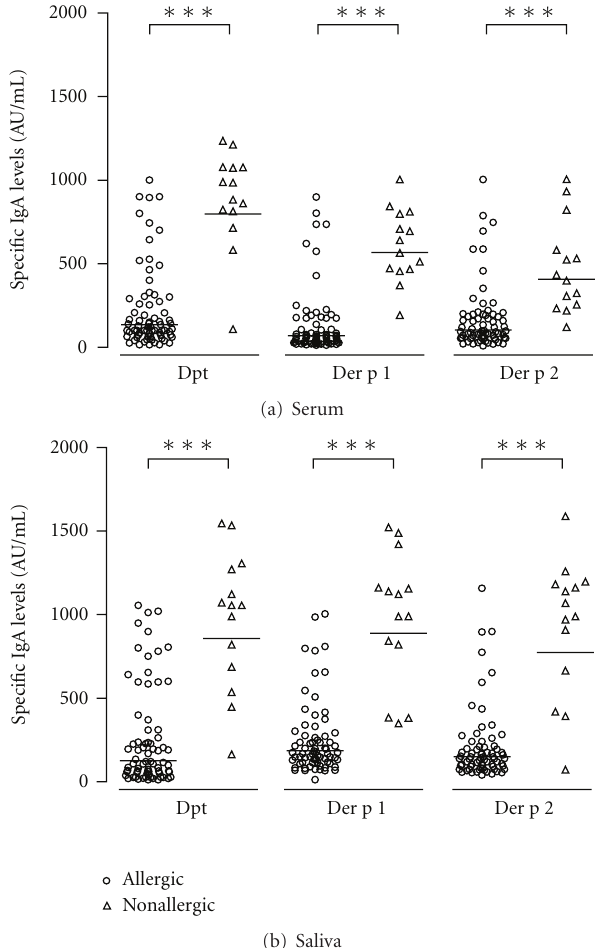
Figure 3: Levels of IgA antibodies to Dermatophagoides pteronyssi- nus (Dpt) crude extract and its major allergens (Der p1 and Der p2) in serum (a) and saliva (b) samples from allergic ( n = 72) and nonallergic ( n = 14) infants. Data are expressed in arbitrary units per milliliter (AU/mL) and the geometric mean for each allergen is indicated by horizontal bars. ∗∗∗ P < 0 . 0001 as determined by the Mann-Whitney U